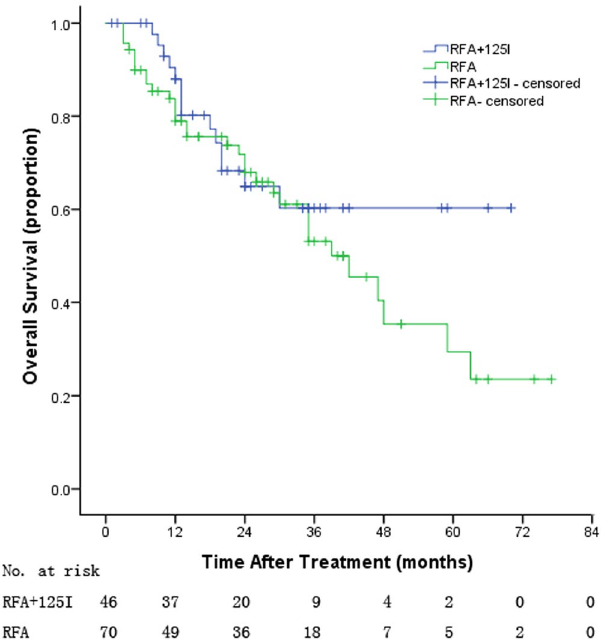
Figure 3. The overall survival of the two groups